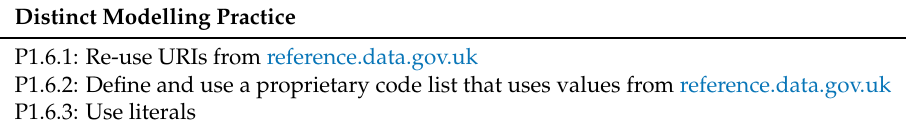
Table 15. Distinct modelling practices of data portals for populating the temporal dimension.